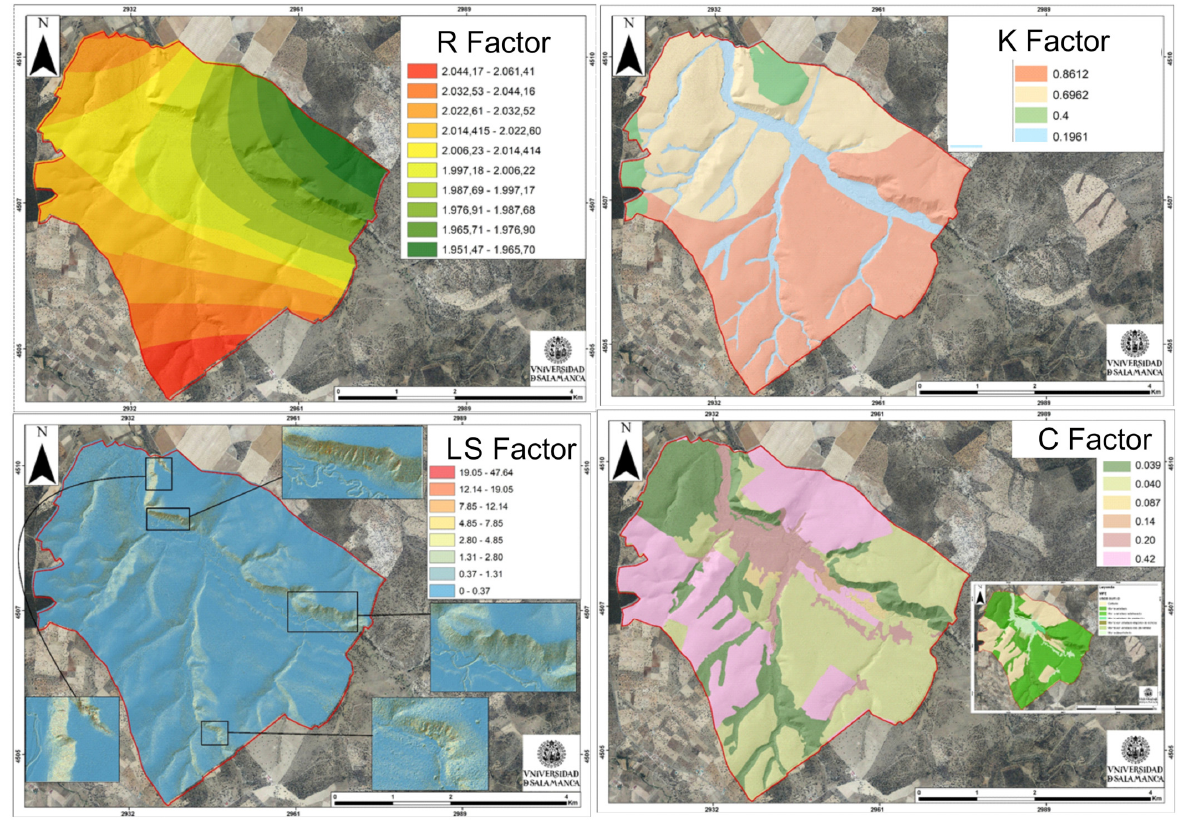
Figure 8. Cartographies obtained from the different factors of the RUSLE in the study area (red border line).